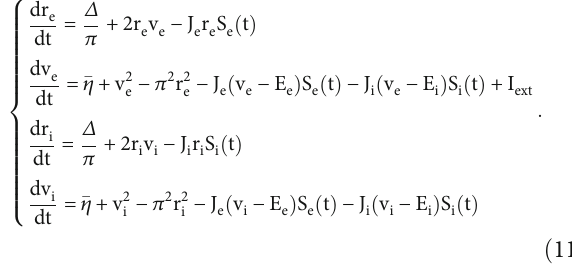
- J plane. f : fold bifurcation curve (red); h ext e